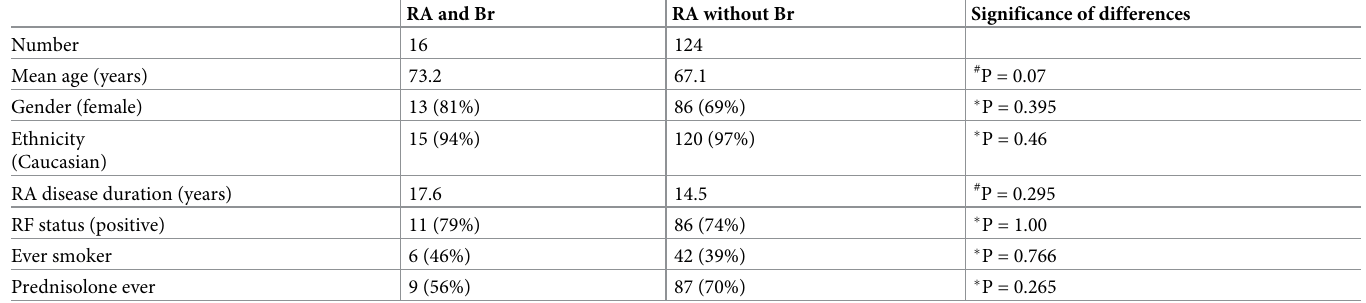
Table 1. Demographics and disease characteristics. The significance of differences was determined by Fisher’s exact test for categorical variables � and by unpaired t tests for continuous variables # . RA and Br